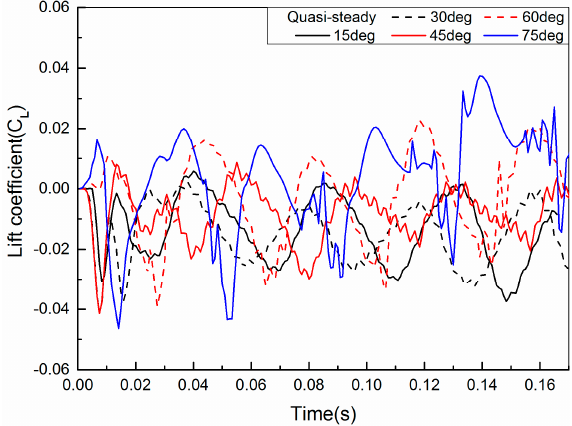
Figure 13. Time history of the wing lift coefficient calculated by the quasi-steady method.